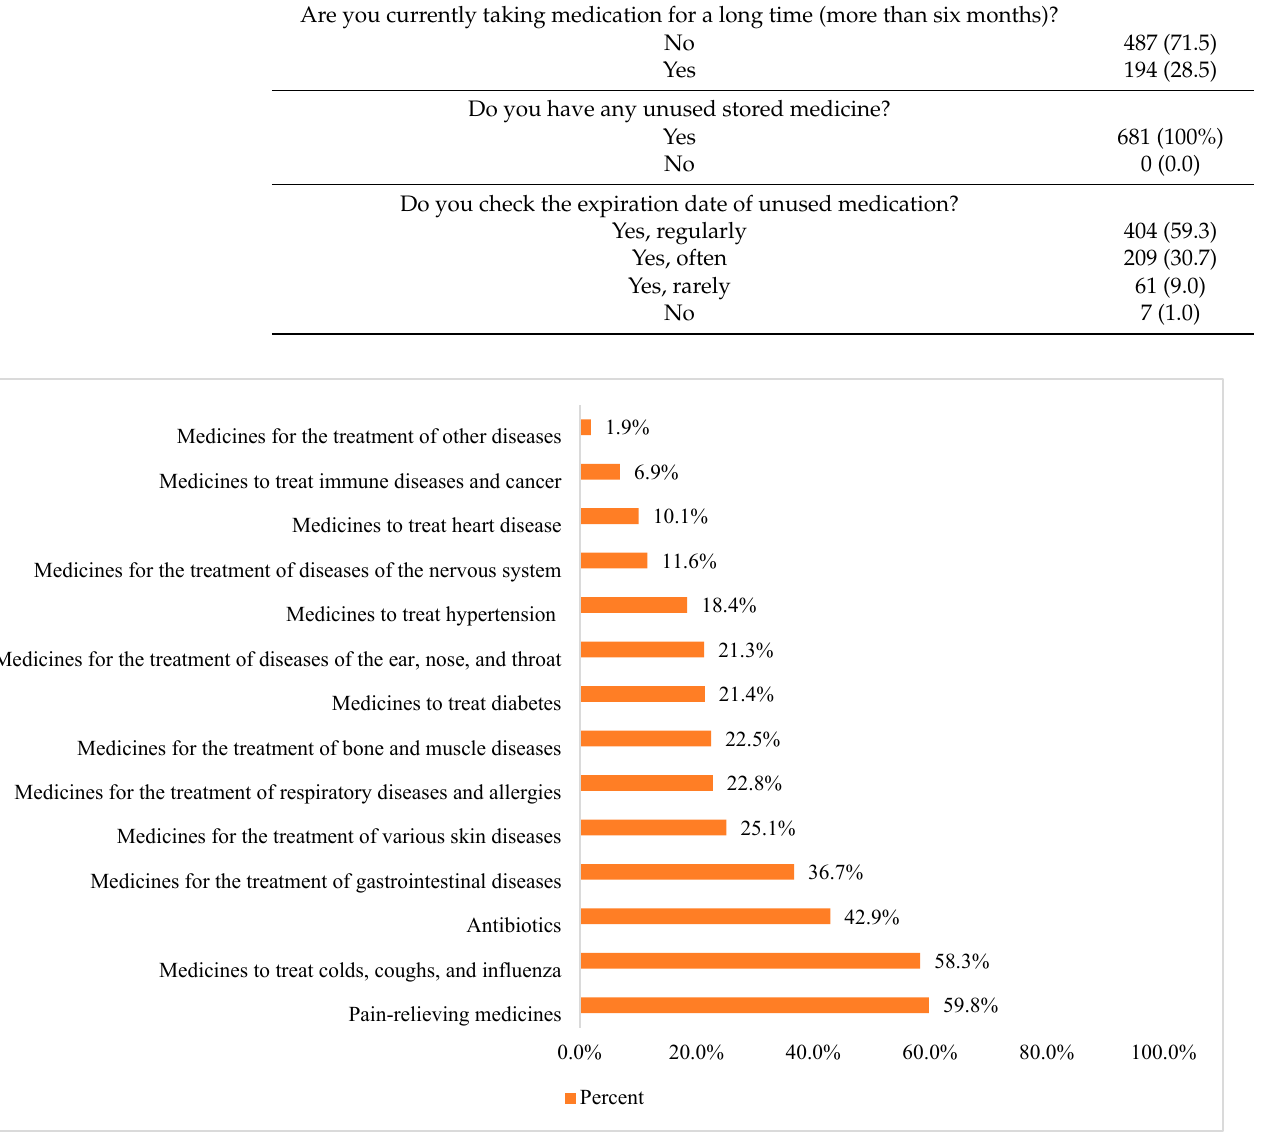
Figure 1. Pharmacological types of unused medicines by study participants (note: participants could select more than one option).